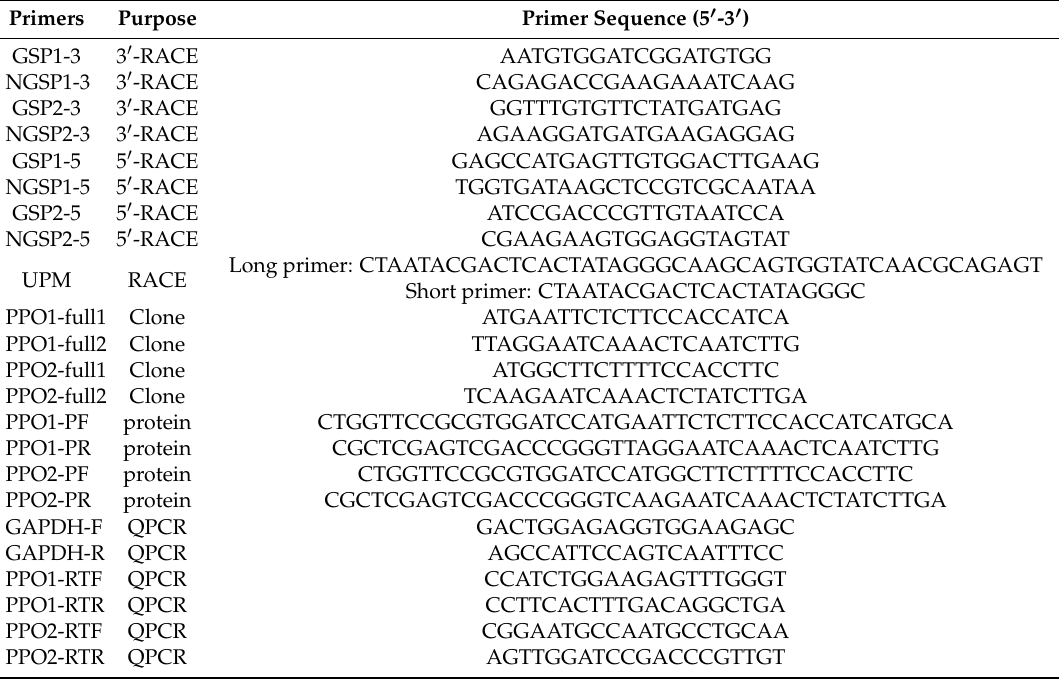
Table 2. Primers used for cloning and analysis of CsPP1 and CsPPO2